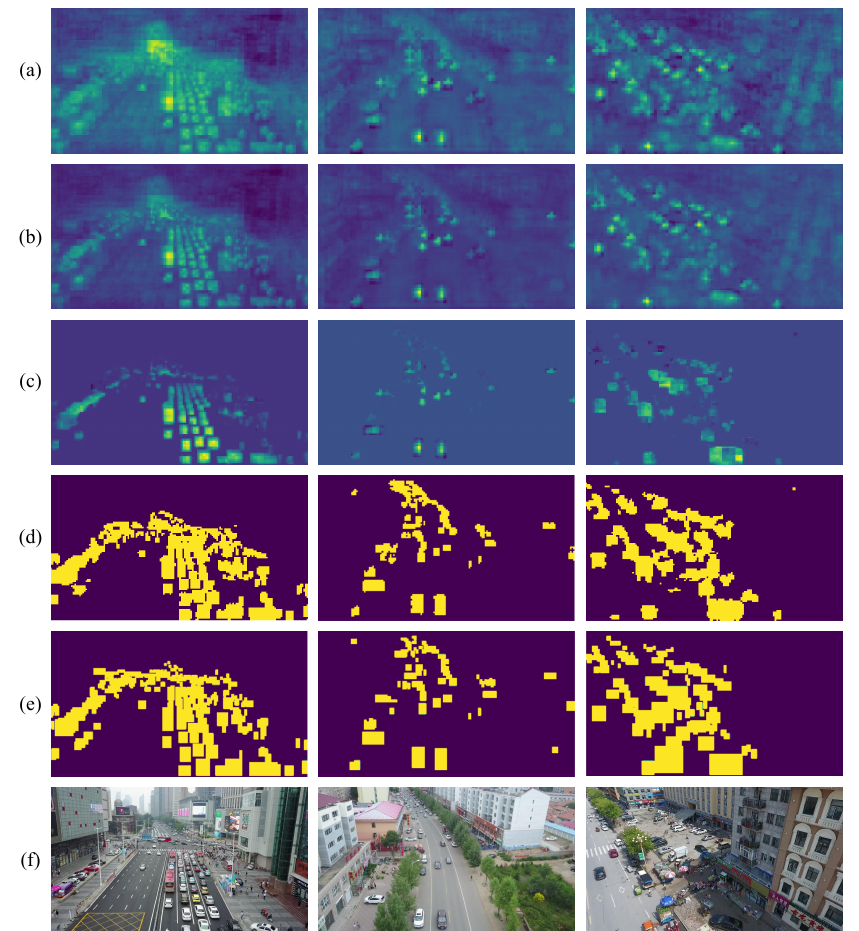
Figure 8. Visualization of the results obtained with our TFB module. ( a ) The feature map input to TFB. ( b ) The output feature map without TFB. ( c ) The output features to TFB. ( d ) The object mask generated by BFR. ( e ) The ground-truth object position without their category. ( f ) The original